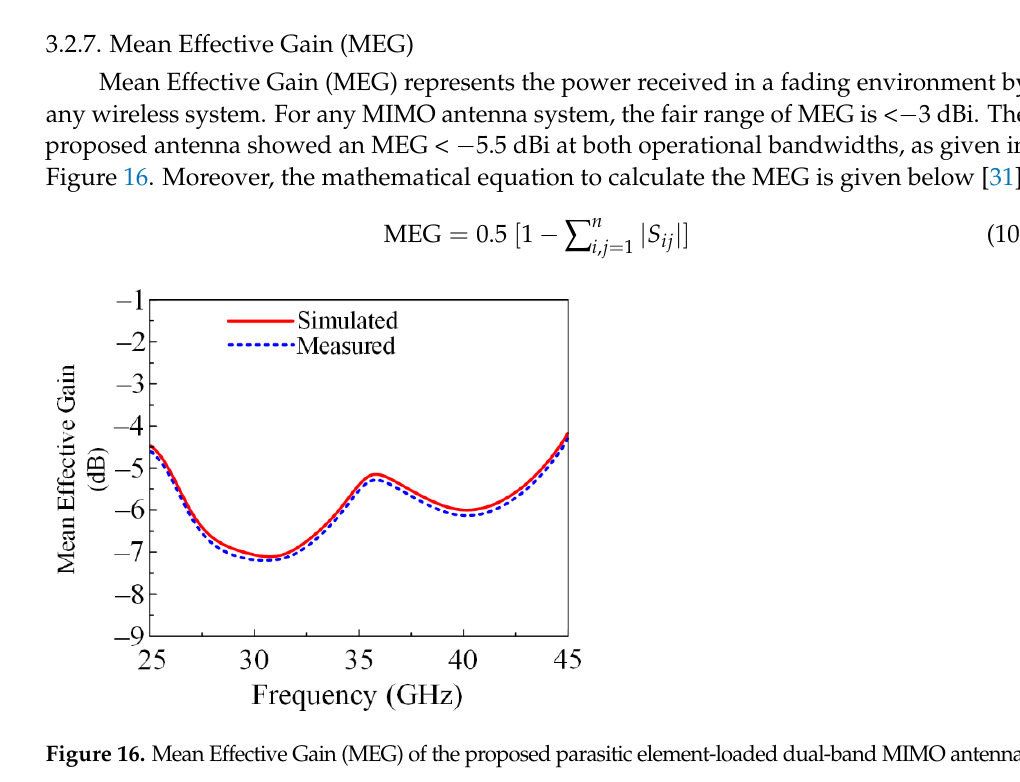
Figure 15. Channel Capacity Loss (CCL) of the proposed parasitic element-loaded dual-band MIMO antenna.